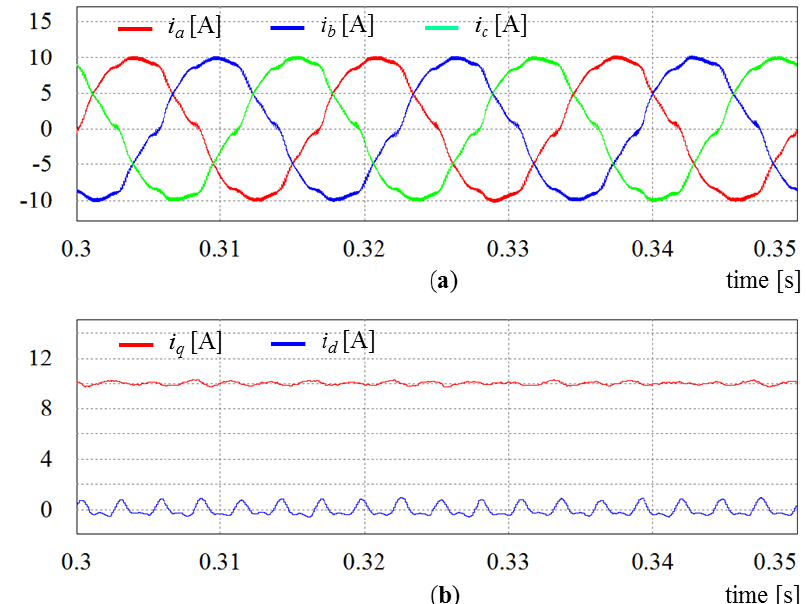
Figure 10. Inverter currents of the conventional PI decoupling controller under the distorted grid voltages: ( a ) phase-currents; and ( b ) q- axis and d- axis currents. voltages: ( a ) phase-currents; and ( b ) q- axis and d- axis